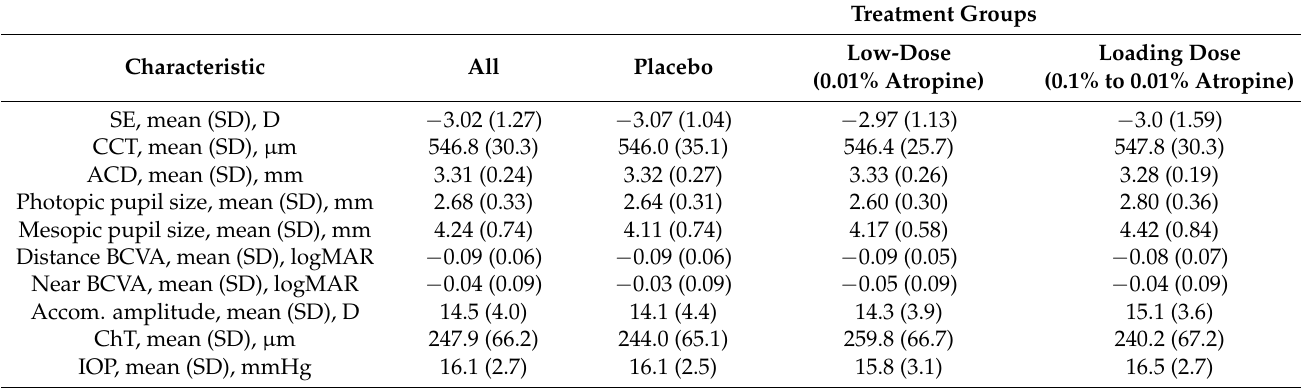
Treatment Groups